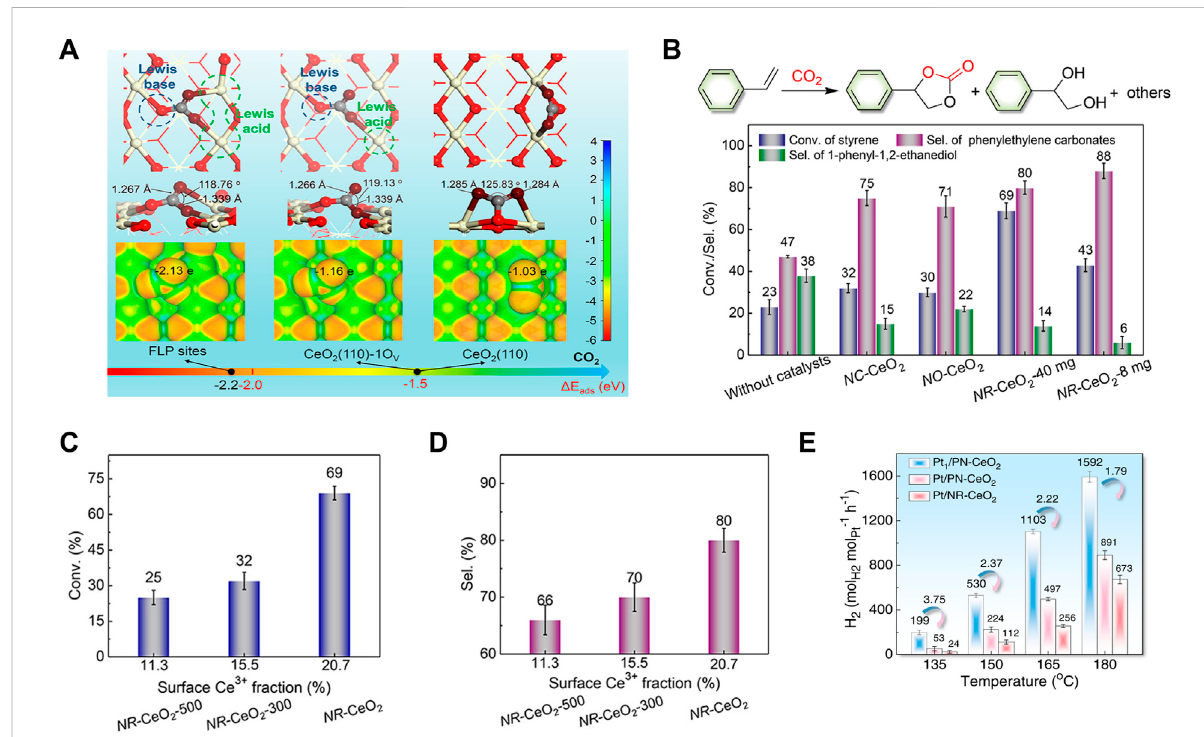
FIGURE 6 Frustrated Lewis acid-base pairs (FLPs) of CeO 2 : (A) FLPs construction and adsorption con fi gurations of CO 2 on CeO 2 (110) with different surface properties. (B – D) Catalytic performance of various CeO 2 catalysts for CO 2 activation for cycloaddition (reaction conditions: styrene (4 mmol), t -butylhydroperoxide (0.65 ml, 70 wt% aqueous solution), tetrabutylammonium bromide (40 mg), CeO 2 (40/8 mg), 80 ° C, 2 MPa CO 2 , 14 h).Reproducedwithpermission(Zhangetal.,2019),Copyright2019,AmericanChemicalSociety. (E) H 2 generationratesatdifferentreaction temperatures catalyzed by Pt anchored CeO 2 catalyst with different Pt sizes or CeO 2 defect concentration. Reproduced with permission (Zhang et al., 2022), Copyright 2022, Springer